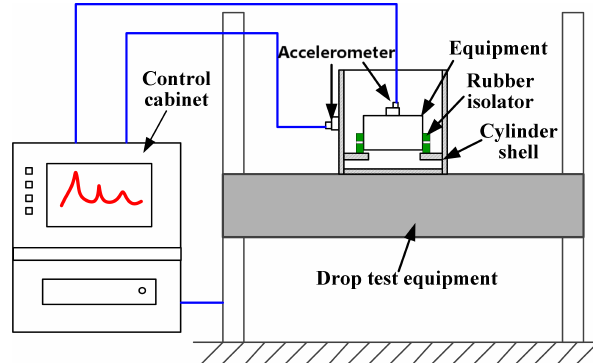
Figure 7. Composition diagram of the drop test system.